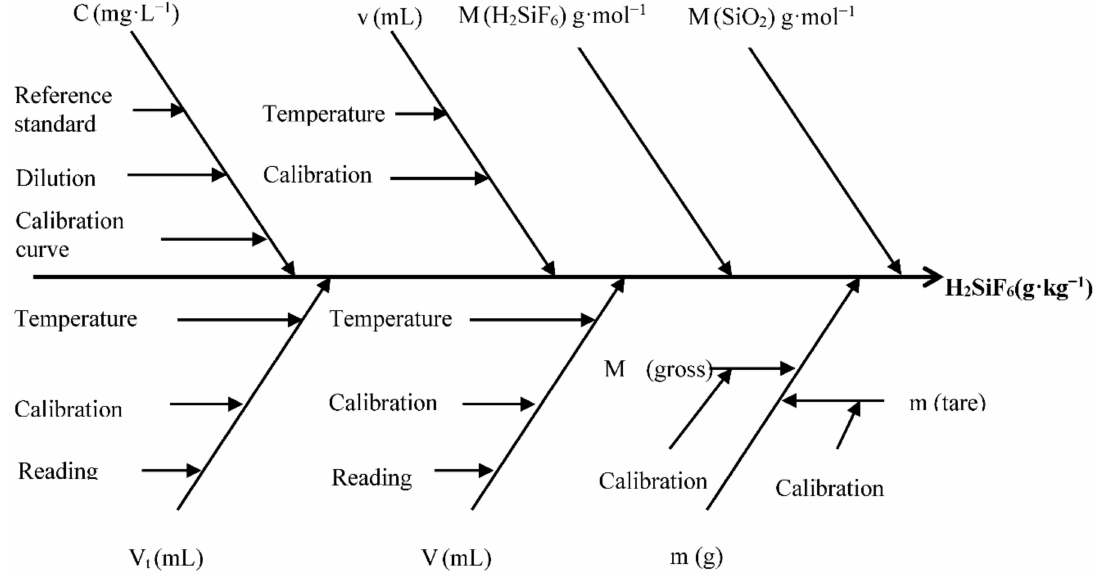
Figure 5. Cause and effect diagram with uncertainty sources of the H 2 SiF 6 mass fraction characterization. The concentration of SiO 2 (C in mg · L − 1 ) is calculated using a calibration curve. The linear least squares fitting procedure used assumes that the uncertainties of the values of the x-axis are considerably smaller than the uncertainty of the values of the y-axis